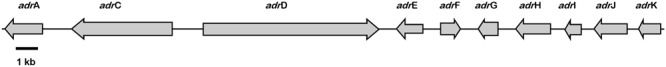
Schematic organization of the adr gene cluster in P. roqueforti CECT 2905. The arrows represent the genes and the direction of their transcription. The organization of the adr cluster in P. roqueforti FM164 (Cheeseman et al., 2014) is identical (data not shown).